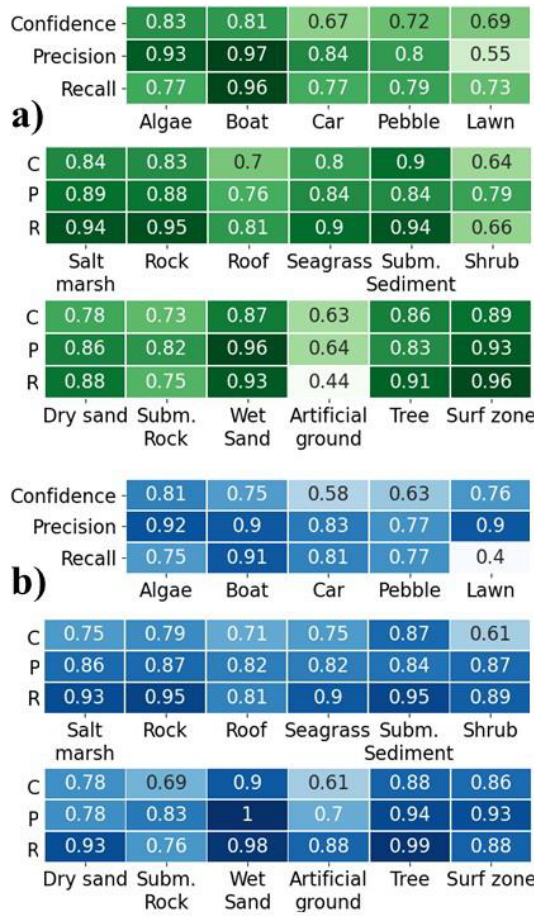
Figure 4. Class-wise classification metrics obtained when using a) green and b) bispectral waveform features as